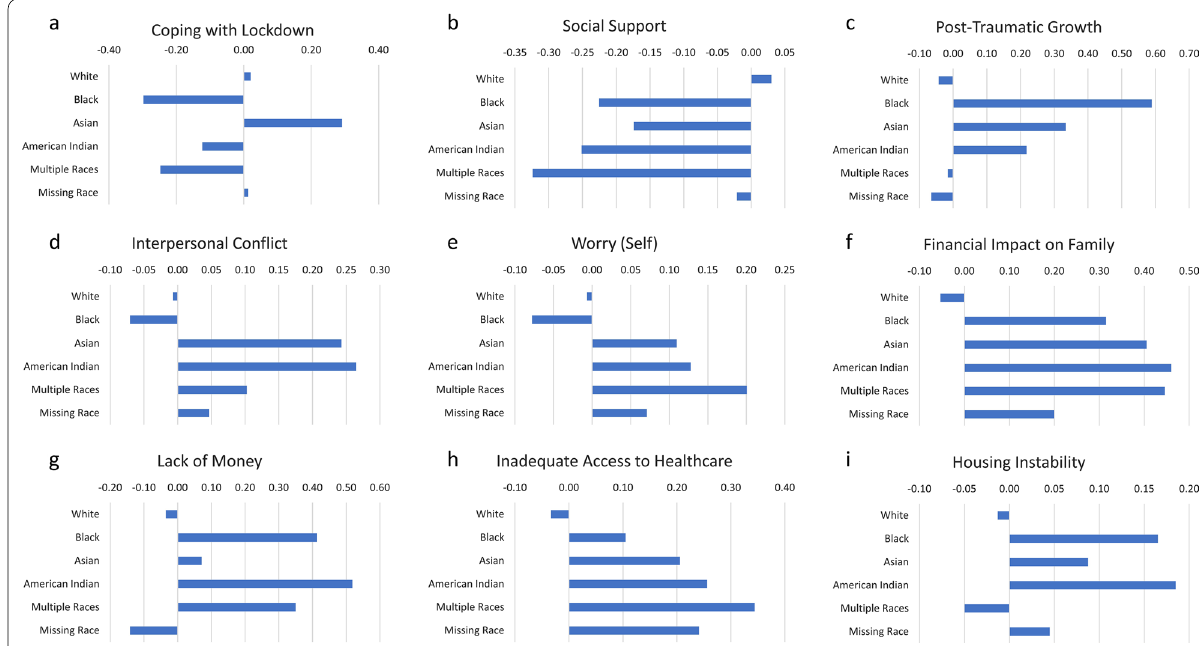
Fig. 2 a – i . Bar chart of racial group differences on COVID-specific variable mean scores. There were marked differences on average levels of all variables compared to